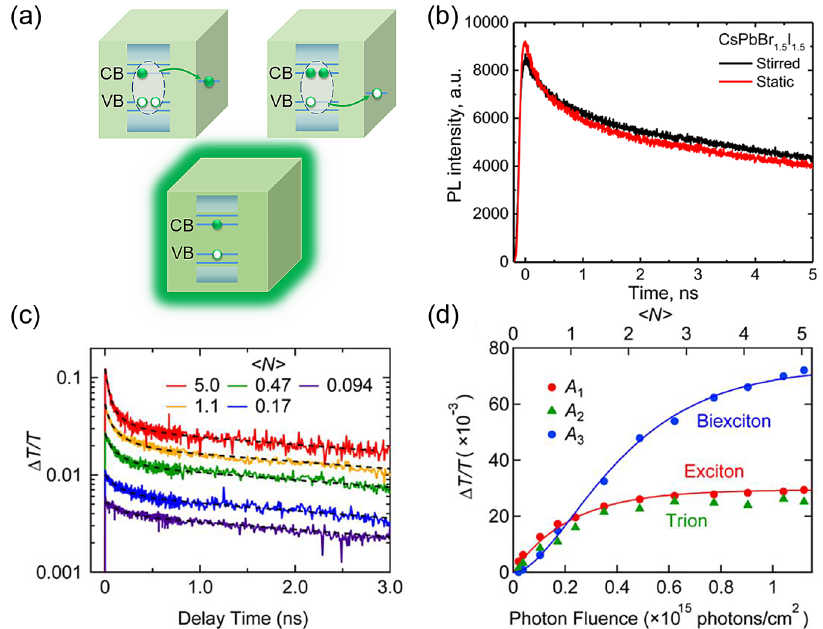
Figure 3: (a) Schematic of a positive trion (upper left), a negative trion (upper right) and an exciton (bottom) excited in a semiconductor nanocrystal. (b) TRPL spectra of the stirred (black) and static (red) solutions of CsPbBr 1.5 I